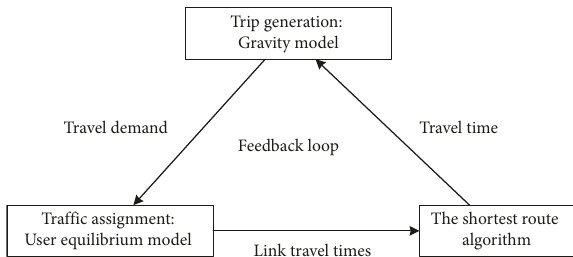
Figure 1: The feedback procedure between nested logit and user equilibrium.